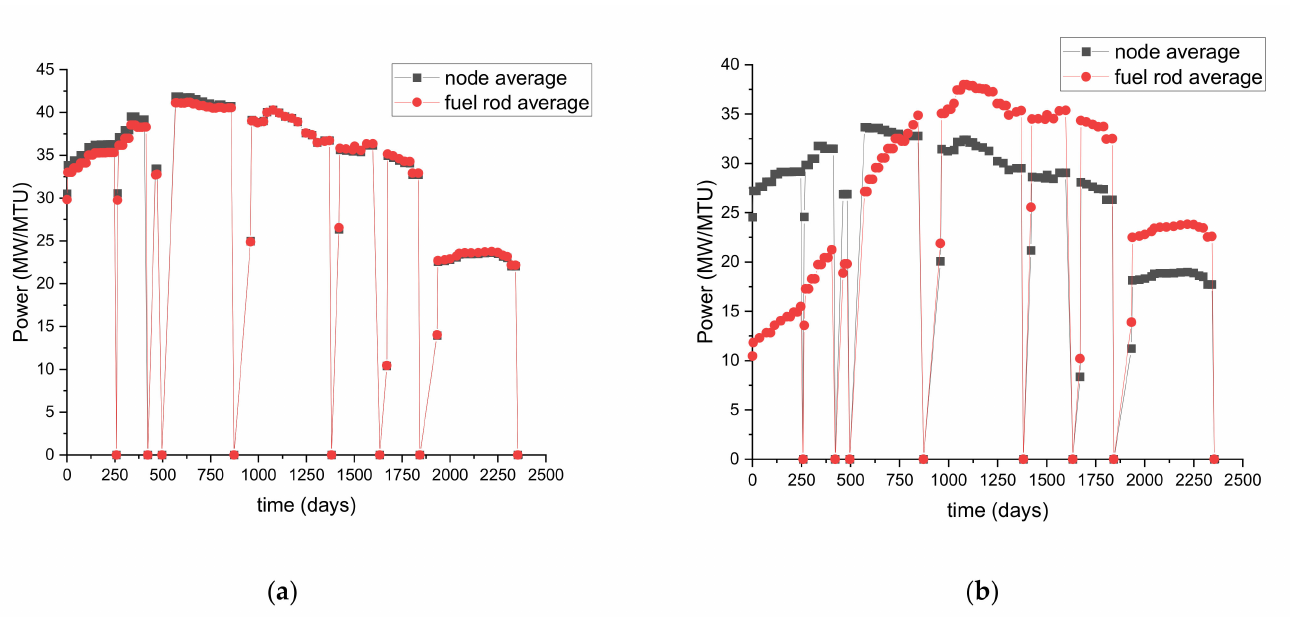
Figure 2. Comparison of sample power history derived from two approaches (based on nodal average power vs. fuel rod power): ( a ) regular fuel sample 2F1ZN3-C3-UM; ( b ) gadolinia fuel sample